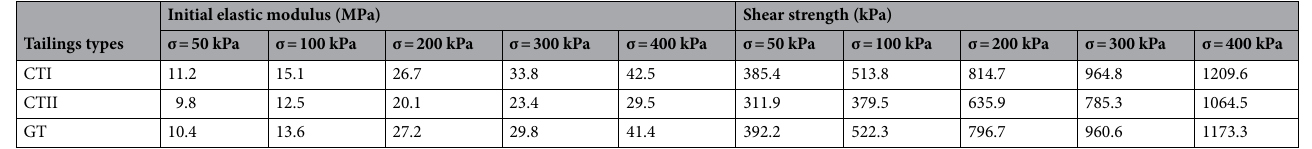
Table 4. Initial elastic modulus and shear strength of tailings (σ = confining